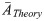
Performance variations of the RMS error for the DoA estimation according to aperture size.The results obtained using A¯Theory and A¯Numeric are indicated by red and blue lines with circular markers, and the results of A¯Measure are specified by black ‘*’ markers. The results of the four-port MRMP array are presented by the green line with square markers.